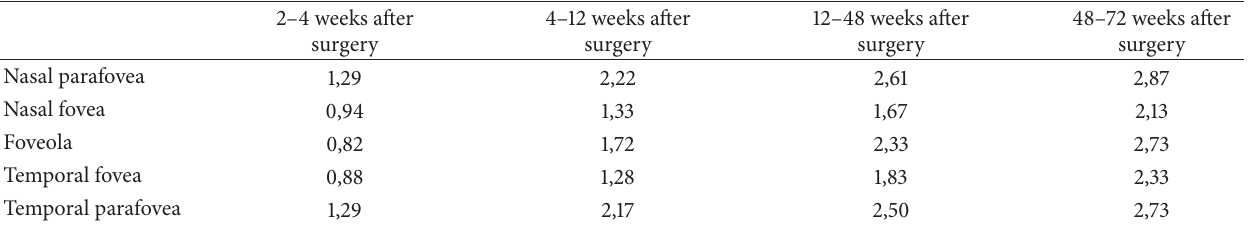
Table 2: The average grade of the IS/OS reflectivity in SdOCT cross-sectional scan running through the foveolar center in relation to follow- up time.